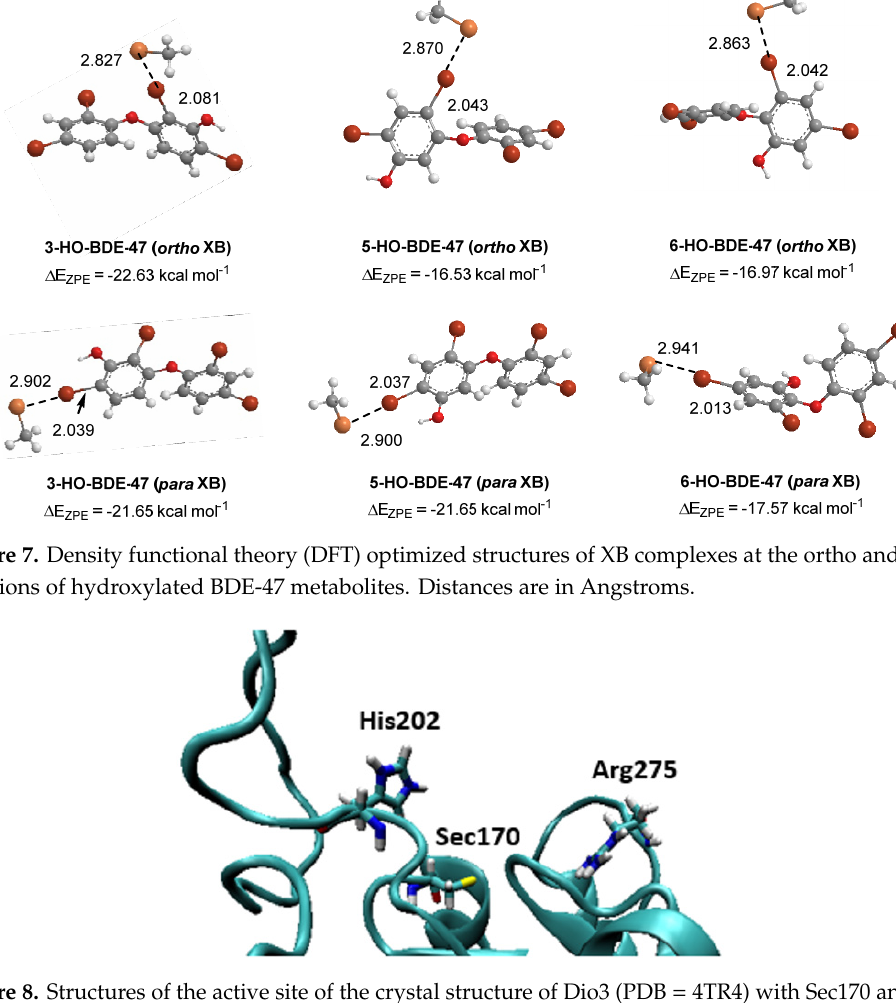
Figure 8. Structures of the active site of the crystal structure of Dio3 (PDB = 4TR4) with Sec170 and